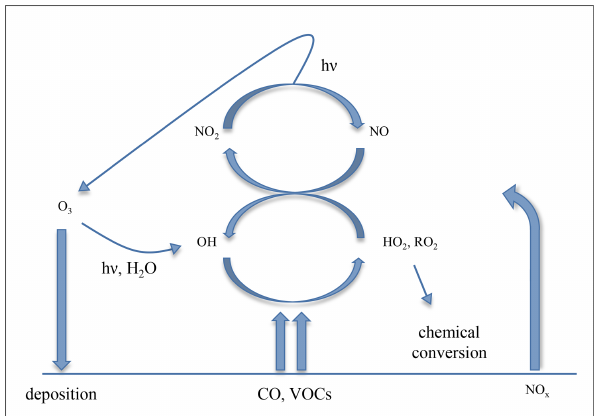
Figure 1. Simplified scheme describing the ozone chemical cycle. Figure adapted and modified from Jacob (2000). See text for elabo-